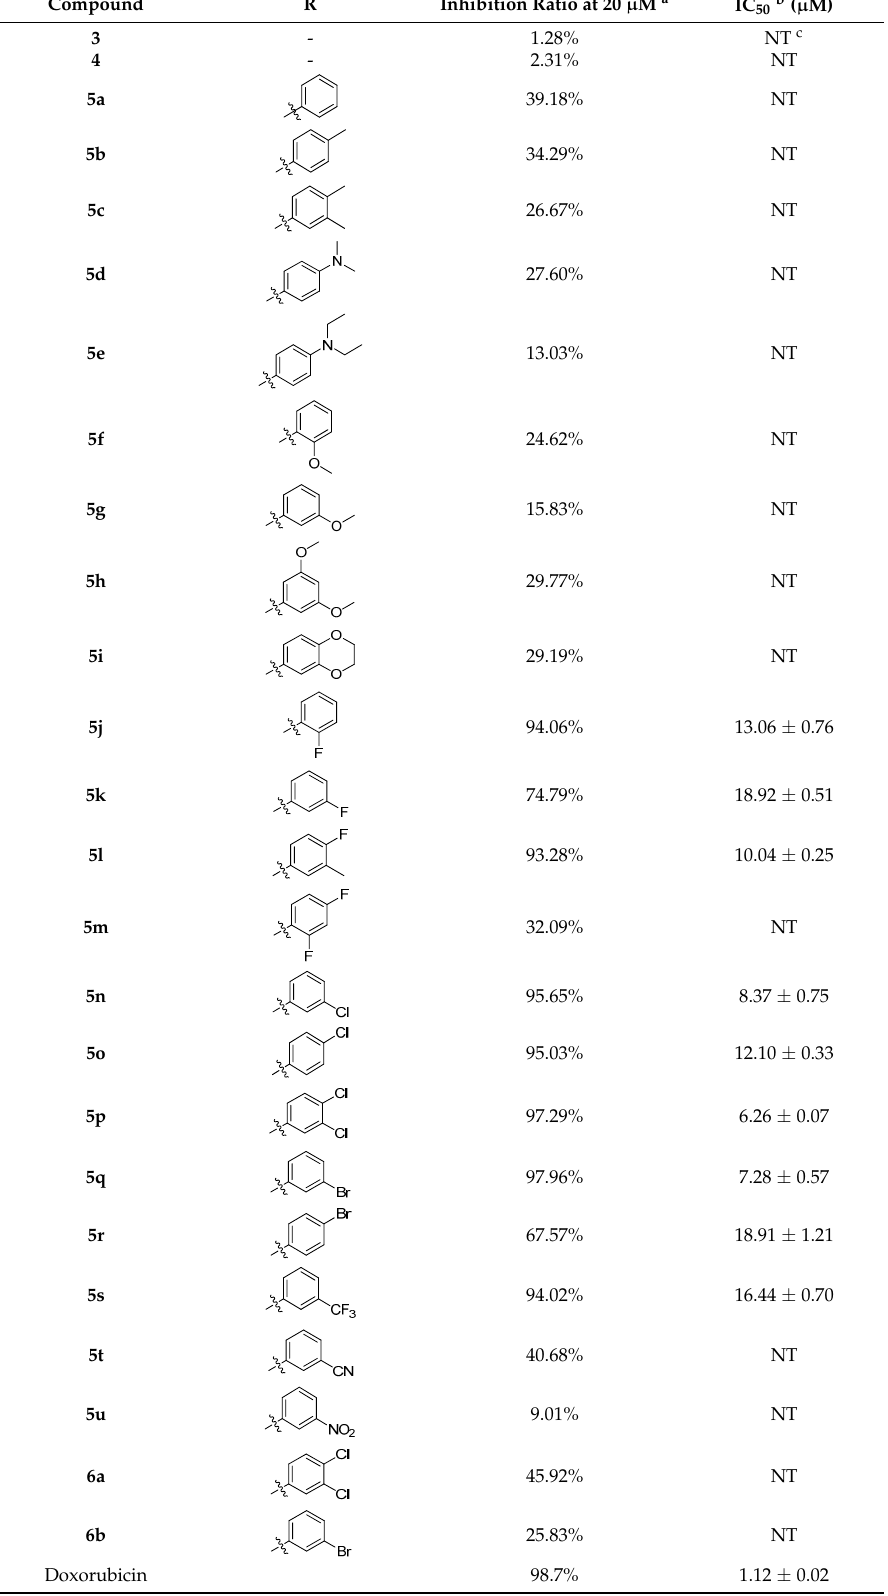
Table 1. Antiproliferative activity of 5a – 5u , 6a , and 6b against A549 cells.